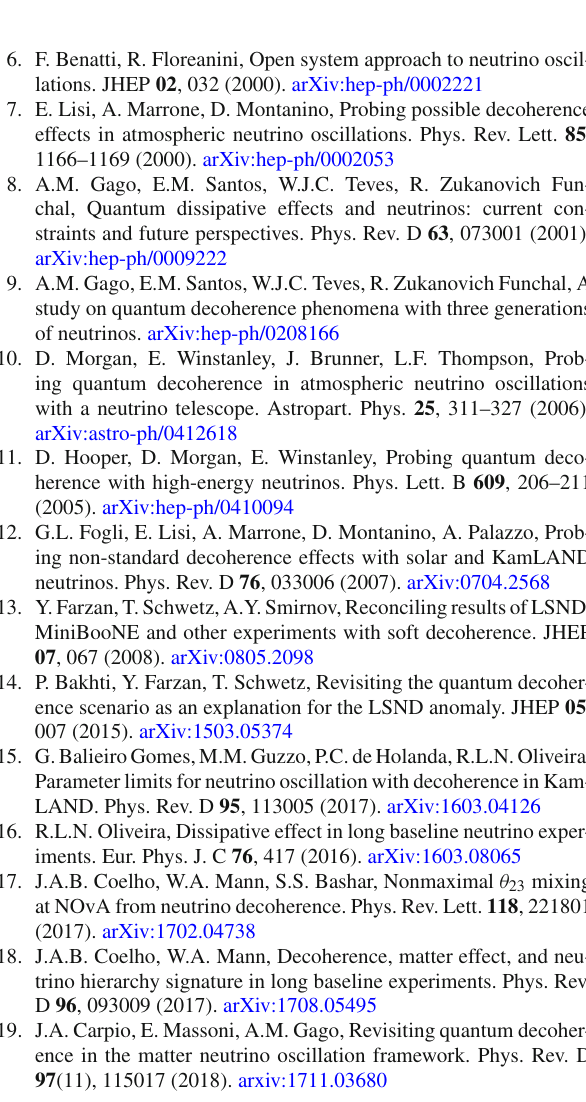
(cid:14) Δχ 2 obtained from the five-dimensional DeepCore analysis Fig. 8 as a function of γ 21 (dashed green curve) and γ 31 (dashed red curve), marginalizing over the rest of the free parameters, for n = 0 and NO.